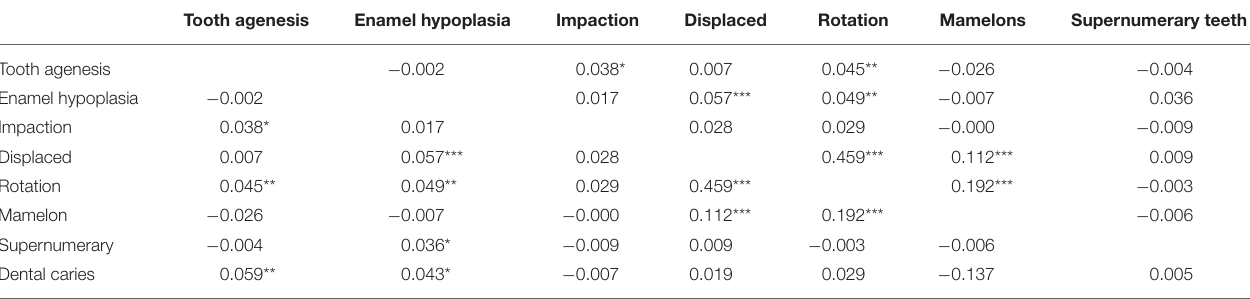
TABLE 4 | Correlation results between the different dental anomalies. Tooth agenesis Enamel